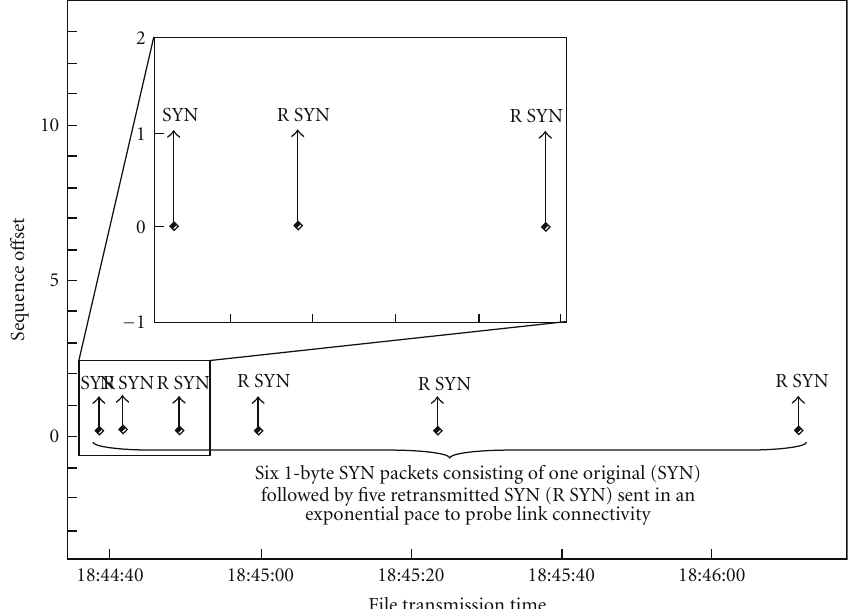
Figure 7: Time Sequence Graph for DTN transmission from MX to RX prior to link disruption over cislunar channels with link delay of 3000 ms and link disruption of 4 hours at BER = 10 − 6 : enlarged view of first series of six 1-byte SYN packets sent by MX to RX during link disruption.